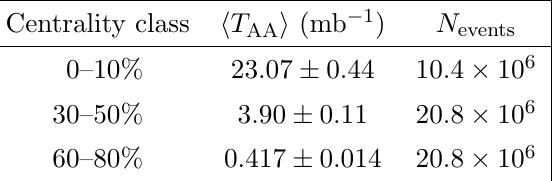
Table 1 . Average nuclear overlap function and number of events for the three centrality classes used in the